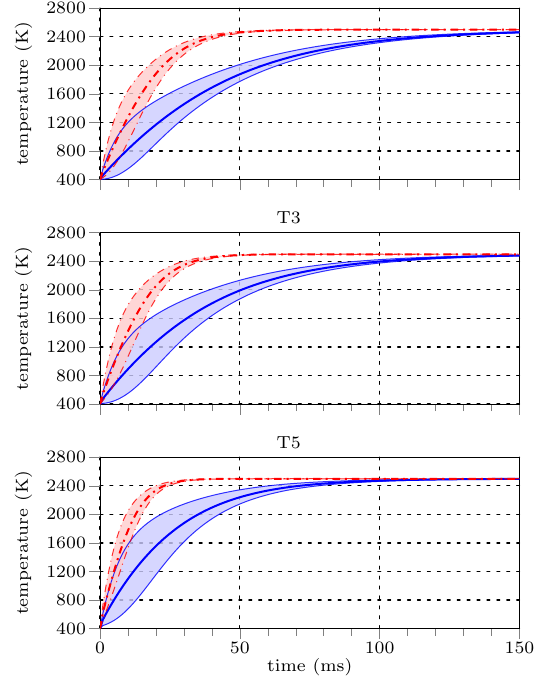
Figure 3. Comparison of mean cluster temperature (solid) and range of individual particle tempera- tures (shaded area) during the heat-up at 0.5 m/s relative velocity ( Re P = 0.29), as defined in Table 1. red ( ): convective and radiative region coupling; blue ( ): convective region coupling.